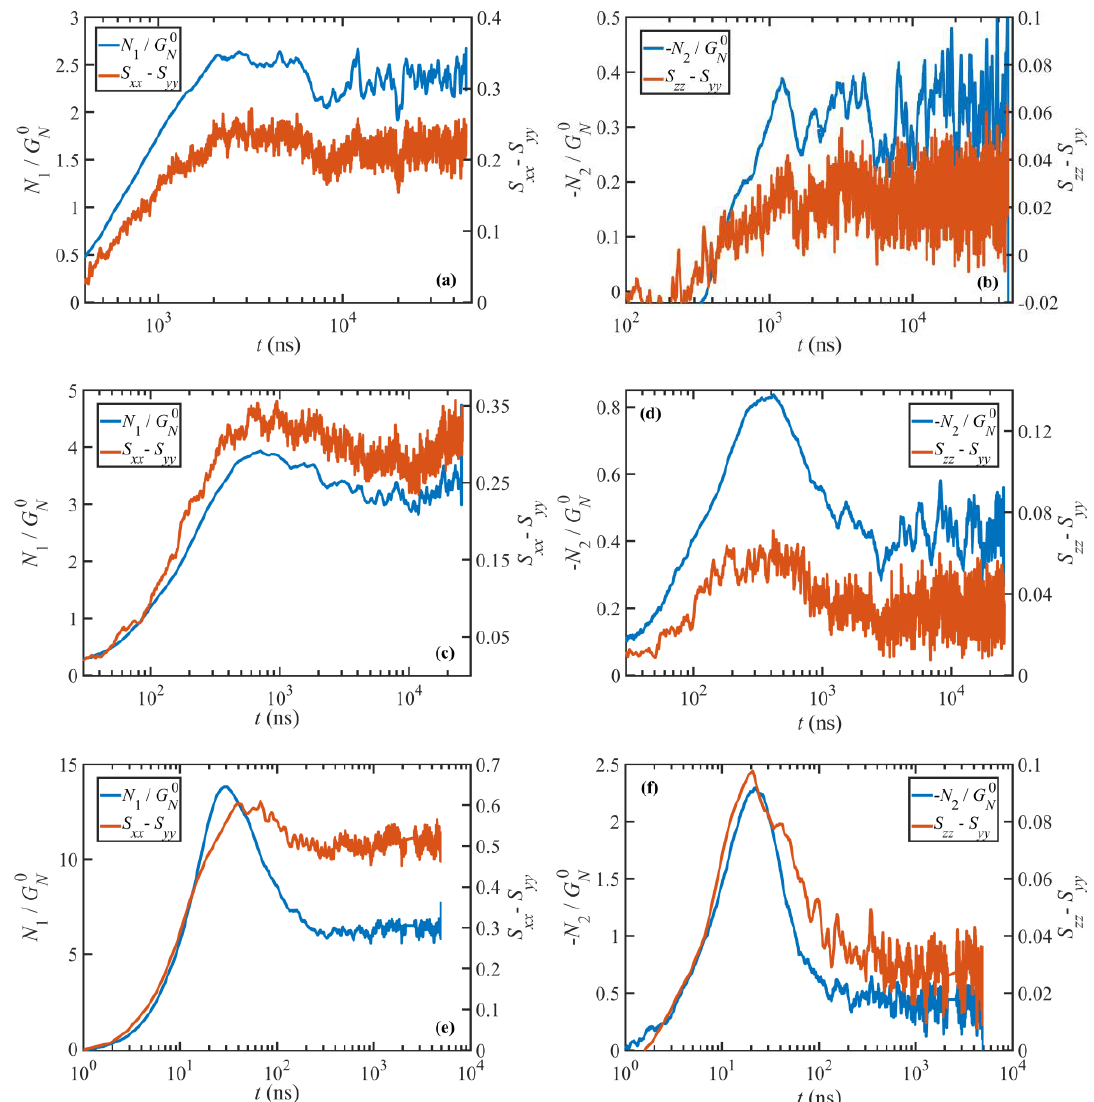
Figure 10. Transient first (left panels) and second (right panels) normal stress differences as well as their corresponding tube orientation tensor differences as functions of time upon startup of shear flow. Normal stress differences are normalized with respect to the plateau modulus. Weissenberg numbers are 12, 58, and 1,170 from top to bottom rows, respectively.